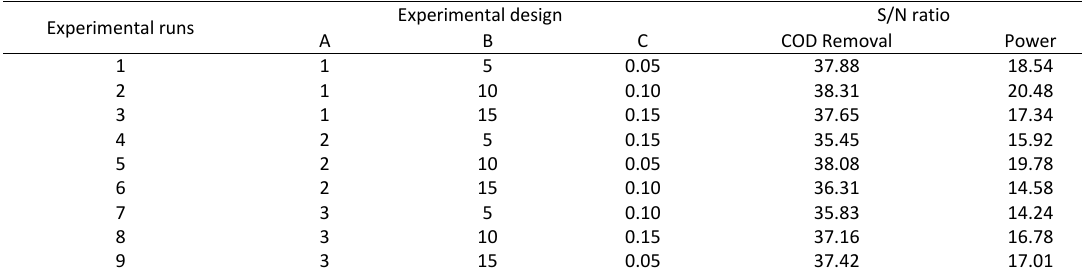
orthogonal designs 9